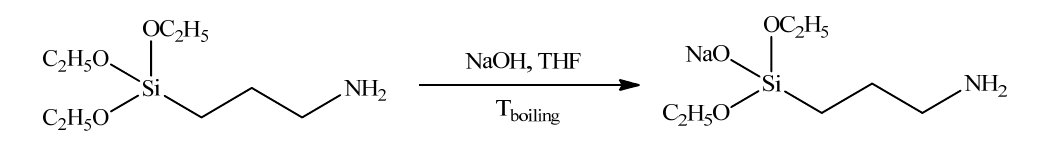
Figure 1. Synthesis of sodiumoxy ‐ (3 ‐ aminopropyl)diethoxysilane.